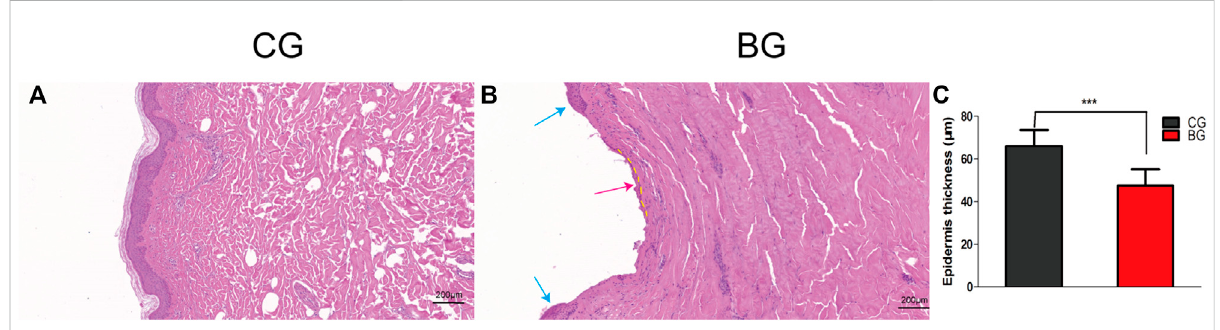
FIGURE 3 (A) NormalskinwasstainedwithHE,andthecorni fi edlayerintheepidermallayerwasintact. (B) BlisteredskinwasstainedwithHEandobserved by light microscopy. The epidermal layer was disrupted (blue arrow) and separated from the dermis, with a small portion of the stratum basale retained (dotted yellow line), which explained the quick recovery of the blistered skin (red arrow). (C) Comparison of skin thicknesses in the two groups. CG: control group; BG: blister group.